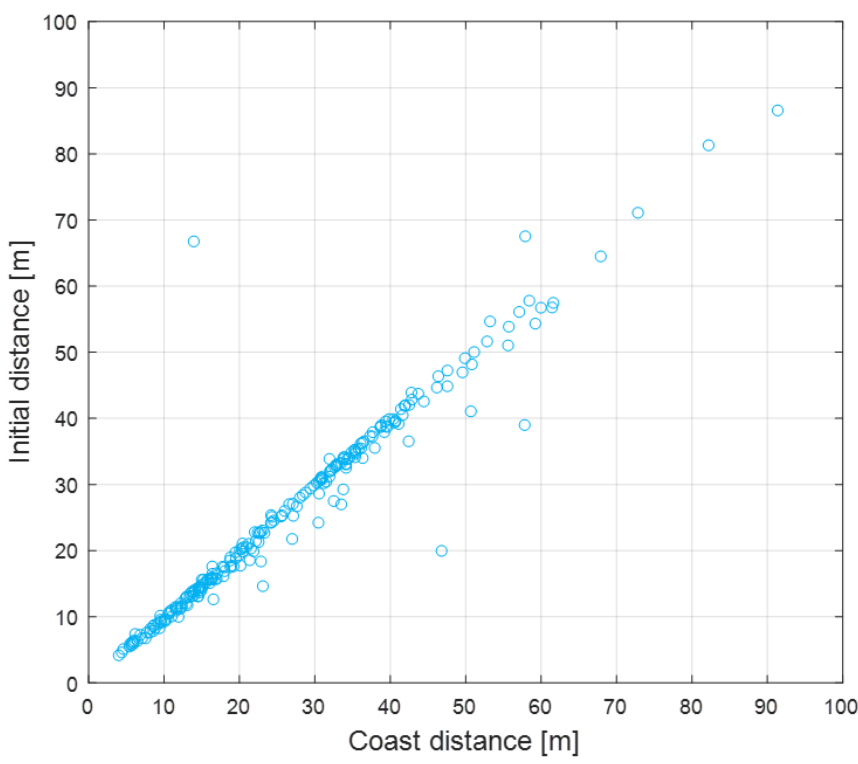
Figure 5. Correlation of coast distance and initial